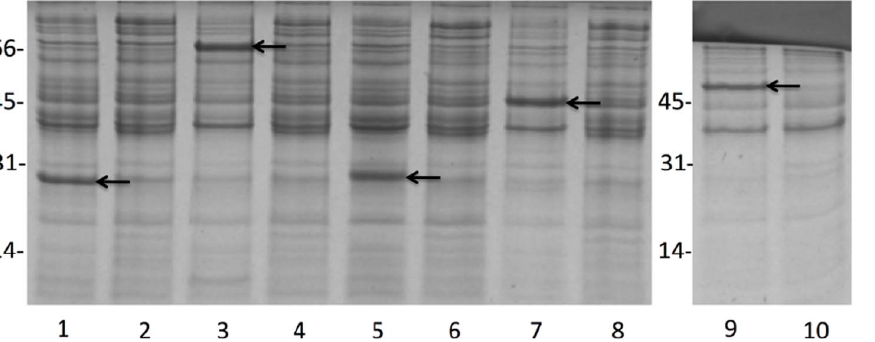
Figure 3. Bacterial lysates from BL-21 E.coli transformed with pTrc-BME constructs and used as inoculums in mouse alveolar type II epithelial cells invasion assays. Bacteria were grown to log phase in LB broth supplemented with antibiotic followed by the addition or exclusion of IPTG and 4 hours of continued incubation. Bacterial lysates were diluted with SDS loading buffer, incubated at 95 u C for 5 minutes and electrophoresed in a 12.5% SDS-PAGE gel. Lanes 1, 3, 5, 7, 9, lysate from BL-21 cells stimulated with IPTG and overexpressing OmpW, BtuB, Omp22, cell surface protein, and FlgK (arrows), respectively. Lanes 2, 4, 6, 8, 10, lysates from non-stimulated BL-21 cells containing protein expression constructs for OmpW, BtuB, Omp22, cell surface protein, and FlgK.